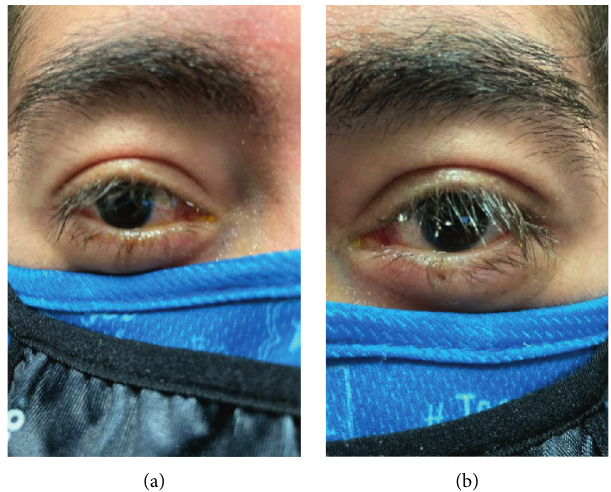
Figure 3: Follow up reveals resolution of severe inferior